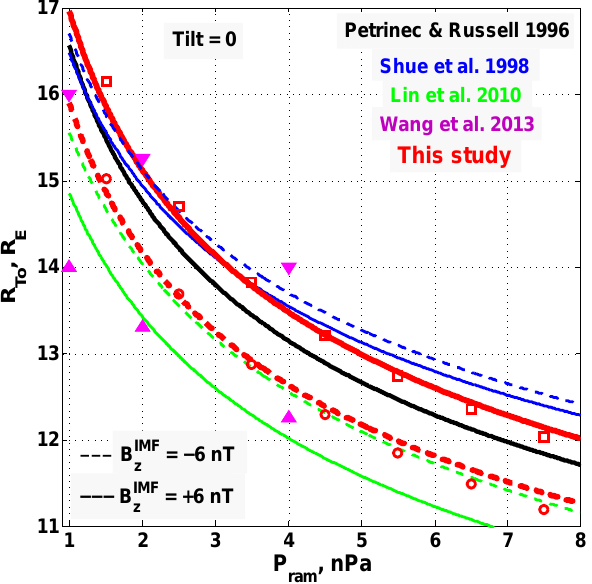
Figure A4. Terminator radius dependence on solar wind dynamic pressure for different empirical models (see the legend). For each model, two profiles corresponding to IMF B z = + 6nT and IMF B z = − 6nT are shown. Dipole tilt is zero. Solid and dashed red lines show the results of the new model developed using the PR96 magnetopause shape for tracing to x = 0. Red empty circles and squares correspond to tracing based on the Shue et al. (1998) mag- netopause